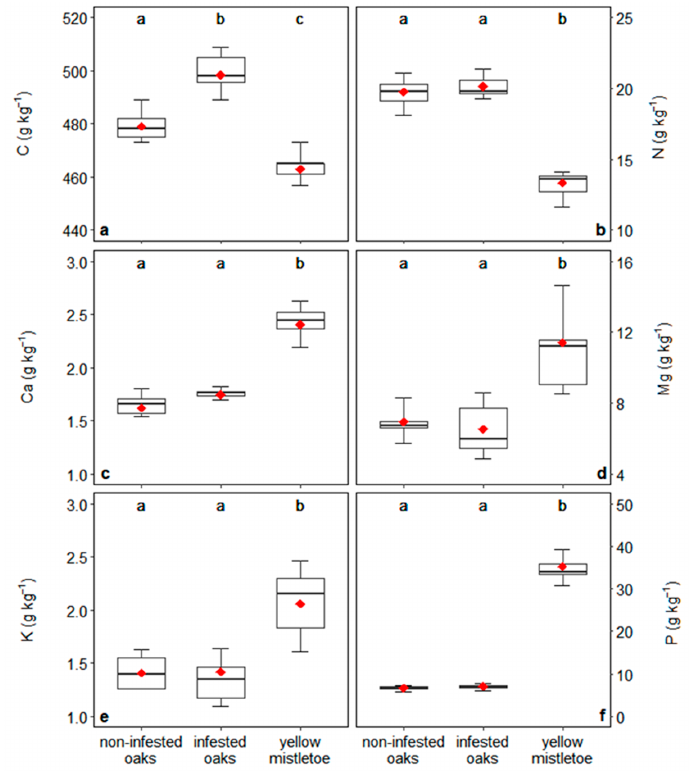
Figure 4. Contents of carbon ( a ), nitrogen ( b ), calcium ( c ), magnesium ( d ), potassium ( e ) and phosphorus ( f ) of non-infested oaks, infested oaks and yellow mistletoes. The median (black line), 25% quantile (box; 37.5–62.5%), 50% quantile (whiskers; 25–75%) and mean (red diamond) are displayed. Lowercase letters represent statistical significance at the level of p = 0.05.